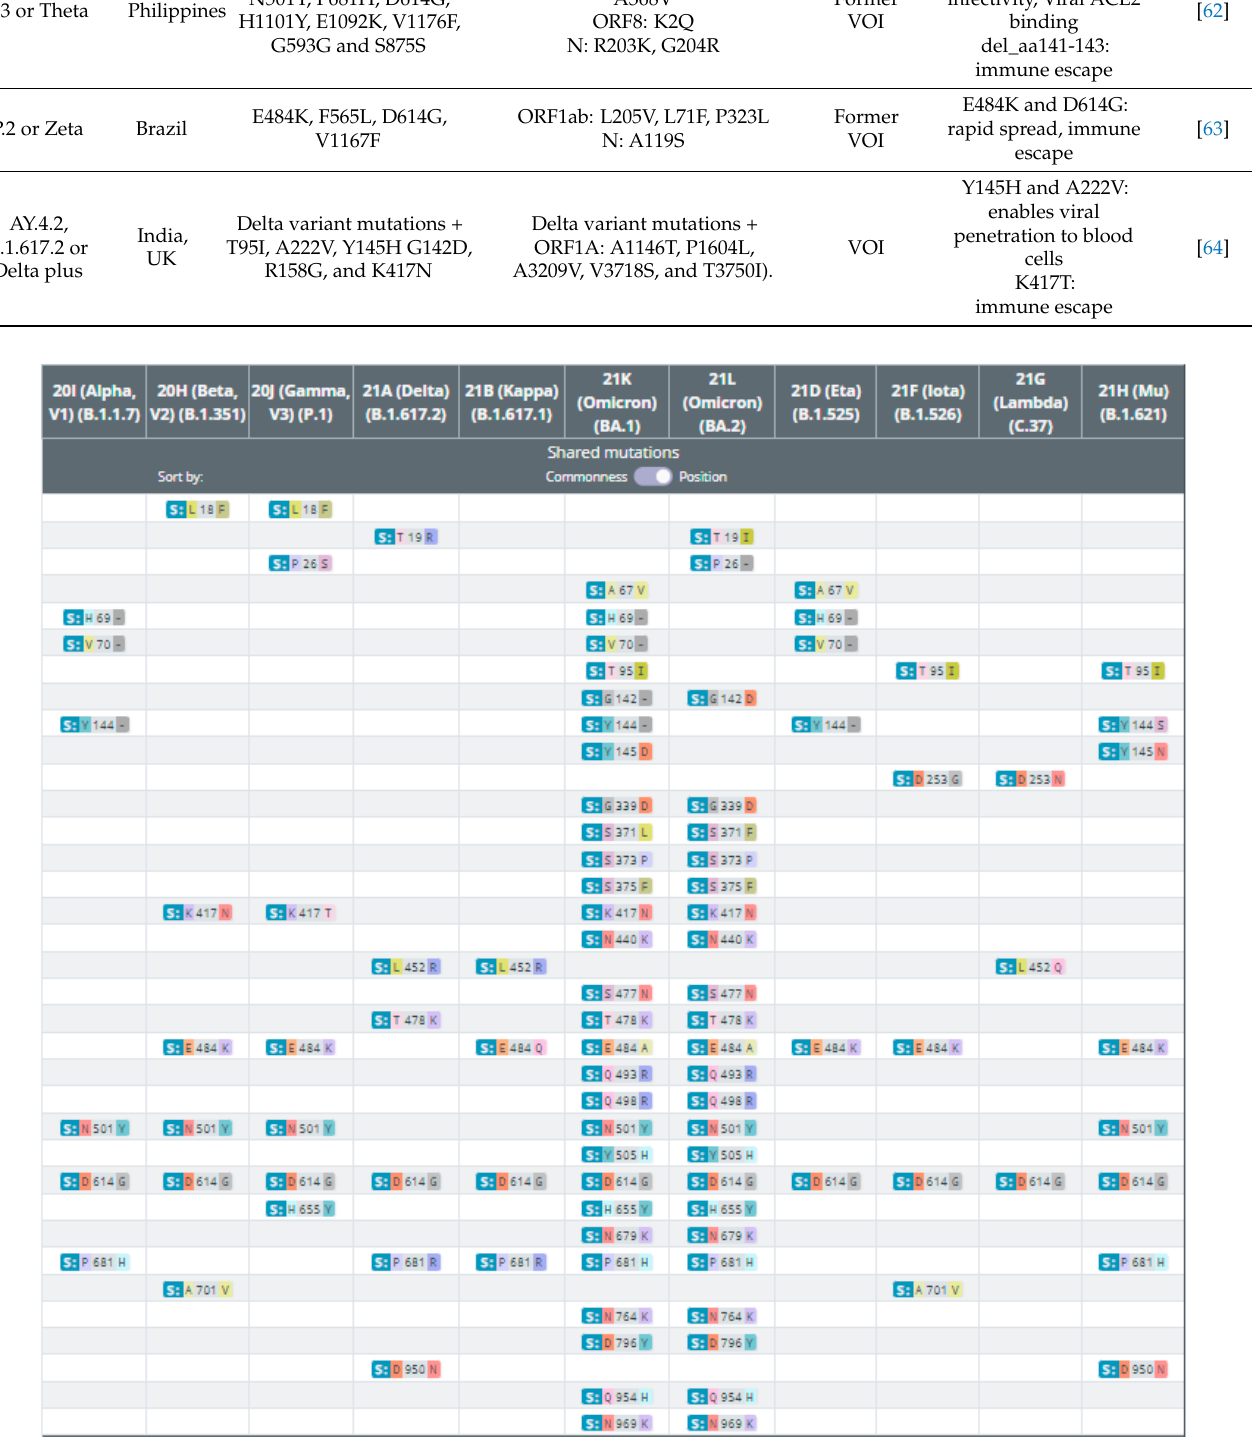
Figure 3. Omicron shares many mutations with four other VOCs, including Alpha, Beta, Gamma, and Delta. and